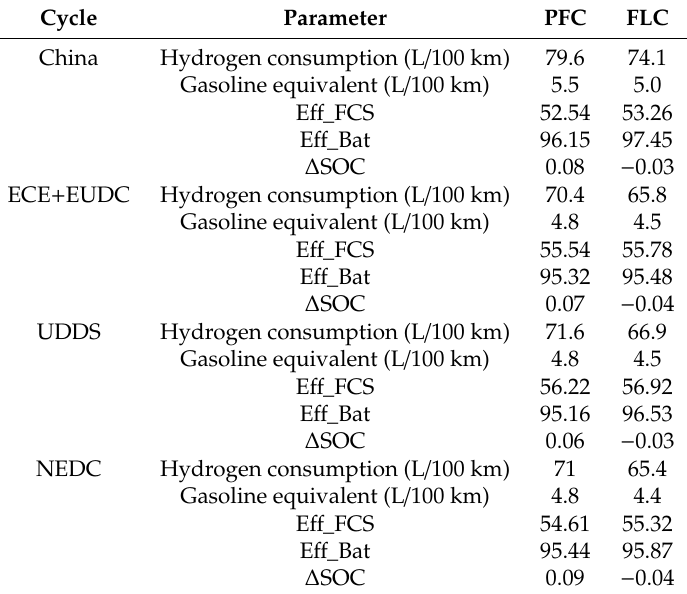
Table 6. Simulation results for di ff erent driving cycles.